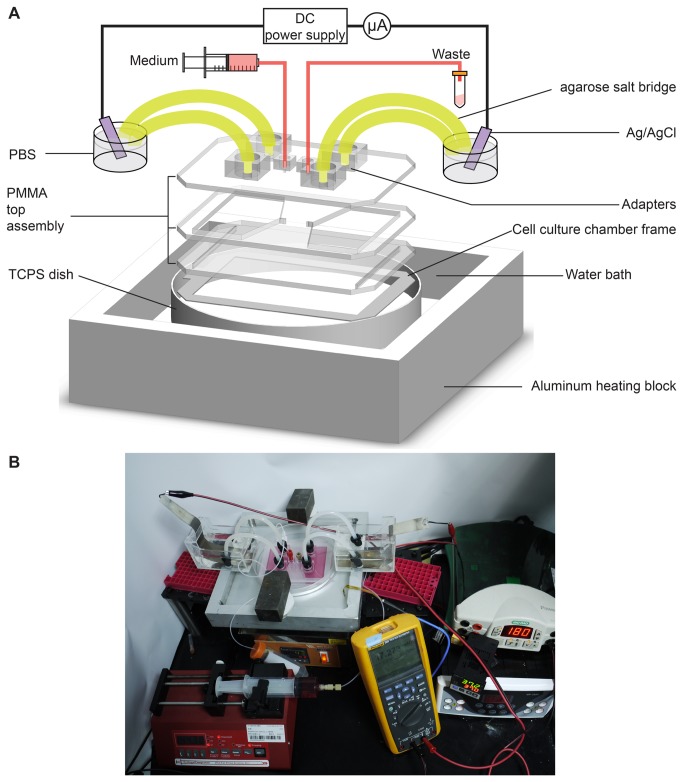
Setup of the electrotaxis experiment using XLEFC.(A) XLEFC is composed of the top assembly, the frame of the cell culture chamber, and a TCPS dish. Stable temperature is provided by water bath. Electric field stimulation is applied by a DC power supply through Ag/AgCl plate electrodes. (B) A photo picture showing the setup on a general laboratory bench.